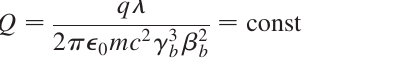
TABLE I. Moments of the KV distribution. All second-order moments not listed vanish (i.e.,